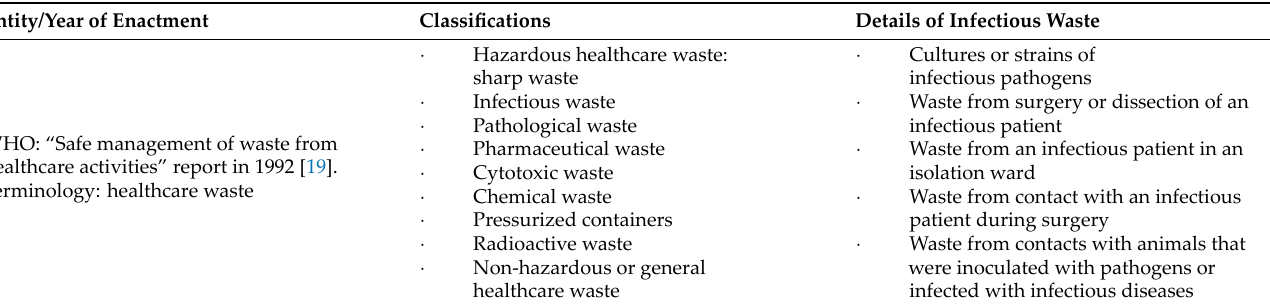
Table 1. Medical waste classifications and related